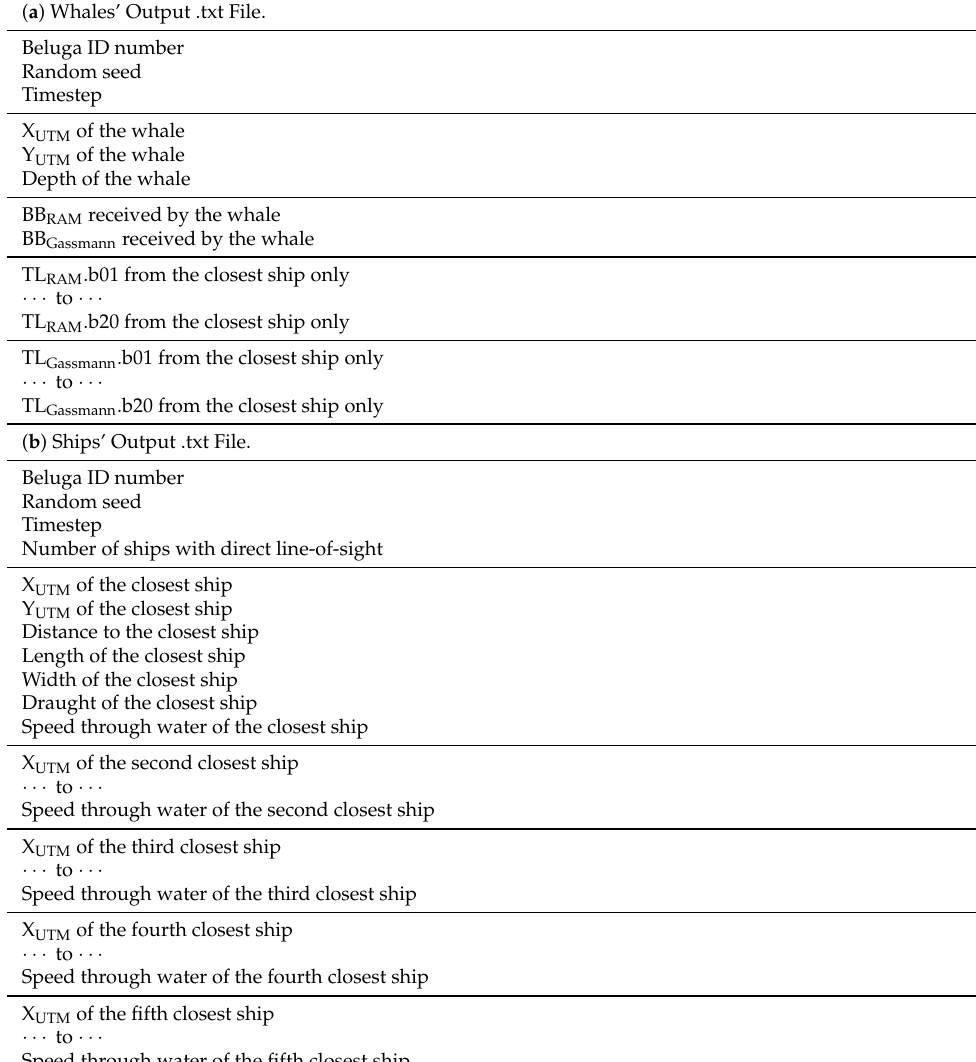
Table A1. 3MTSim’s Output .txt